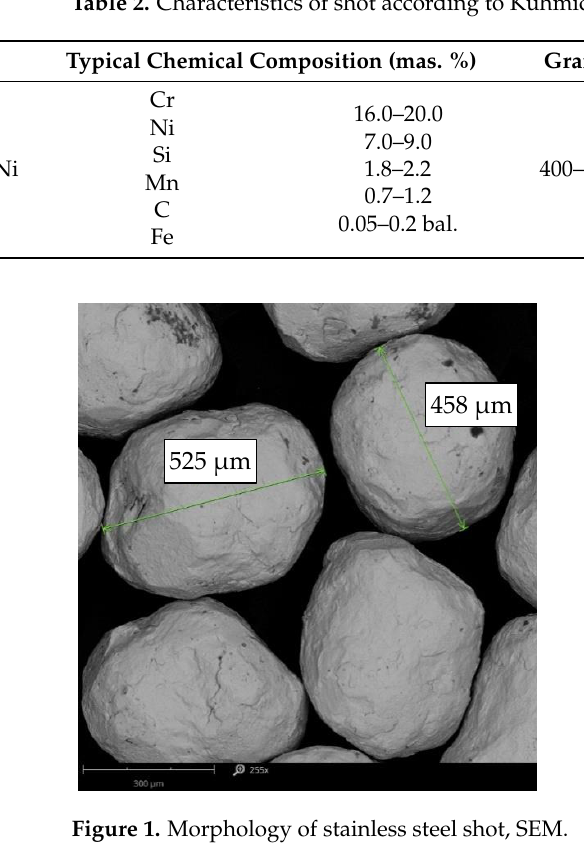
Table 2. Characteristics of shot according to Kuhmichel Abrasiv GmbH.